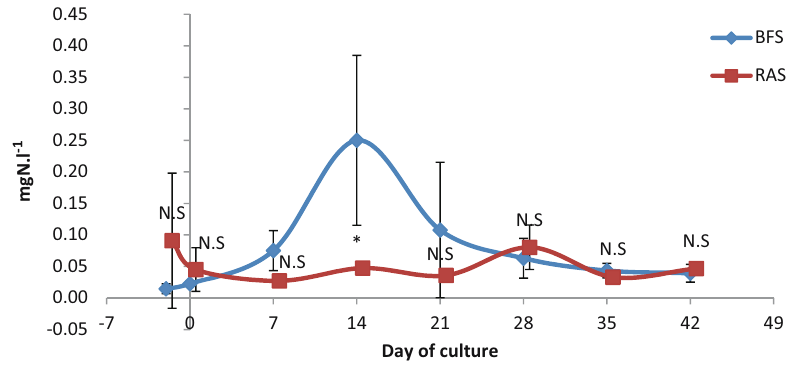
Figure 2: The concentration of total ammonia nitrogen in the rearing water of RAS and BFS measured weekly. N.S means no signi fi cant di ff erence and * means a signi fi cant di ff erence ( p < 0.05 )